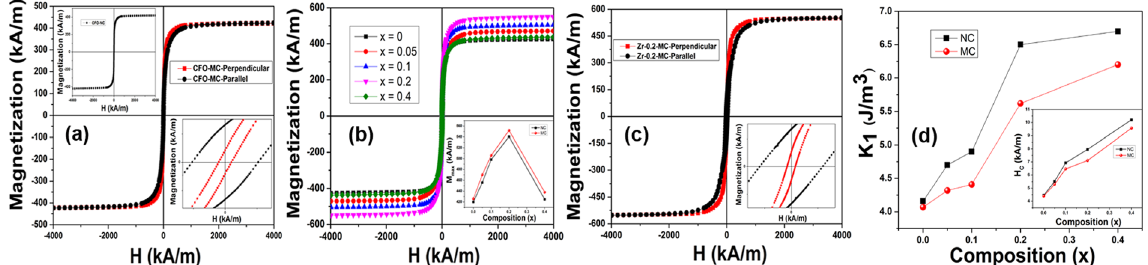
Figure 3. ( a ) Parallel and perpendicular M-H curves of x = 0, inset of ( a ) shows magnetization curve of CFO-NC; ( b ) Magnetization (M-H) curves of Co 1 + x Zr x Fe 2 − 2x O 4 (0 ≤ ×≤ 0.4)-MC samples at room temperature (~300 K); (inset) Variation of M S with composition (x); ( c ) Parallel and perpendicular M-H curves of x = 0.2 composition, ( d ) Variation of anisotropy constant and coercivity (inset) as a function of composition and its comparison with NC samples.